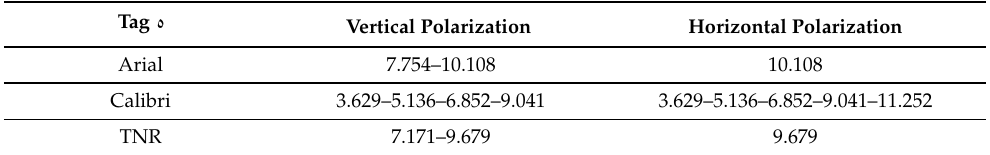
Figure 15. Designed letter (cid:240) tag with various fonts with the same size of 28: ( a ) Arial; ( b ) Calibri; ( c ) Times New Roman (TNR).